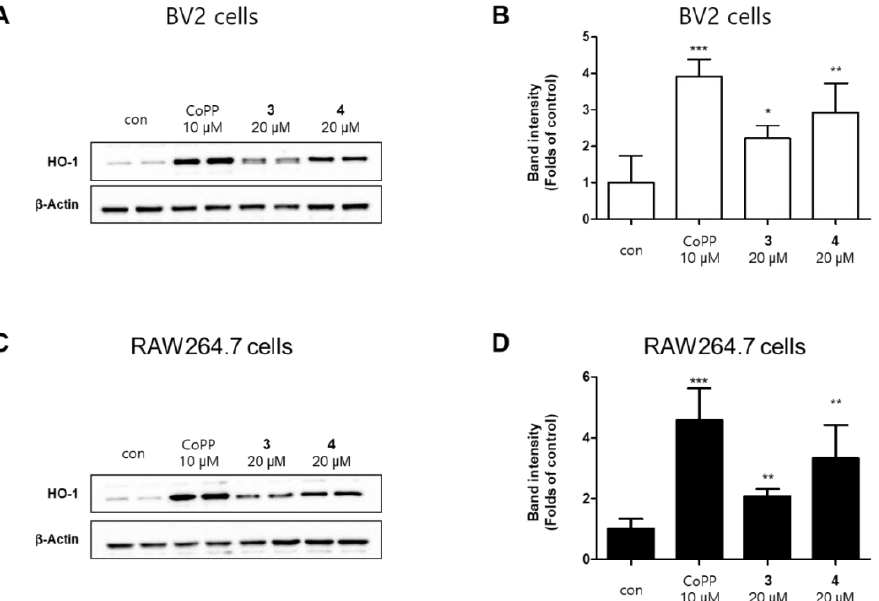
Figure 7. Effects of compounds 3 and 4 on heme oxygenase (HO)-1 expression in BV2 ( A ) and RAW264.7 ( C ) cells. The cells were treated with compounds 3 or 4 or CoPP (10 μM) for 12 h. Representative blots from three independent experiments are shown. Immunoblots were quantified using the ImageJ software. Band intensity was normalized to each total form expression ( B , D ). * p < 0.05, ** p < 0.01, and *** p < 0.001 compared with the control group.